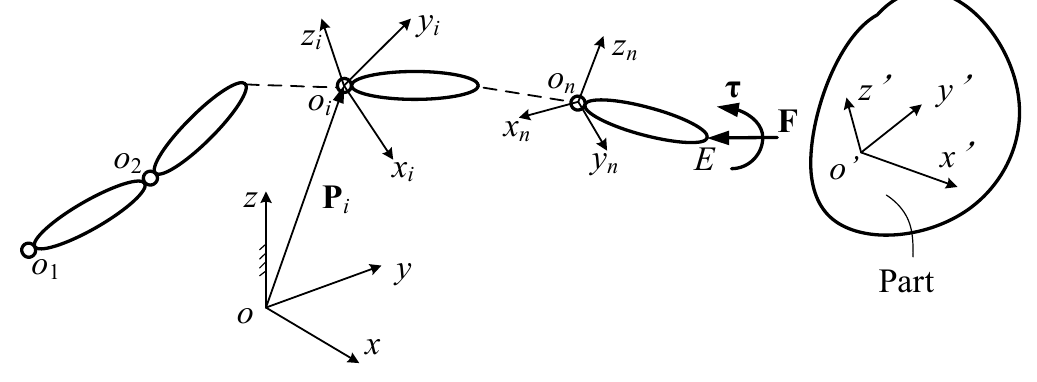
Figure 2. Kinematic scheme.